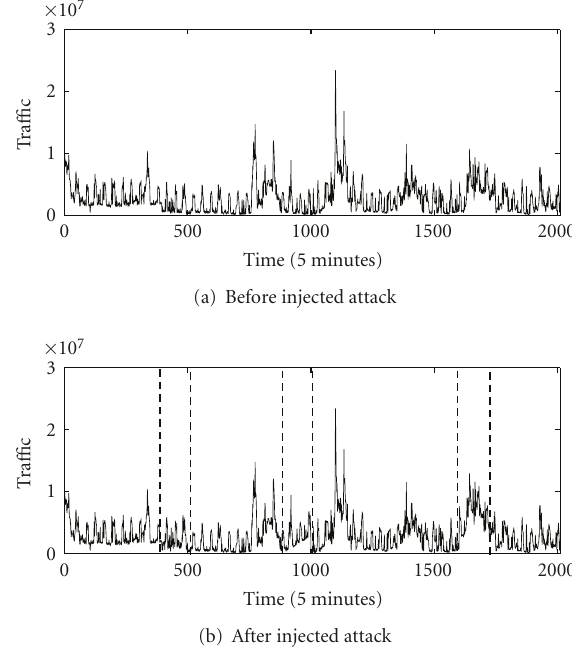
Figure 10: 112 OD flow (6th week) before and after injected non- periodic DDoS attacks.